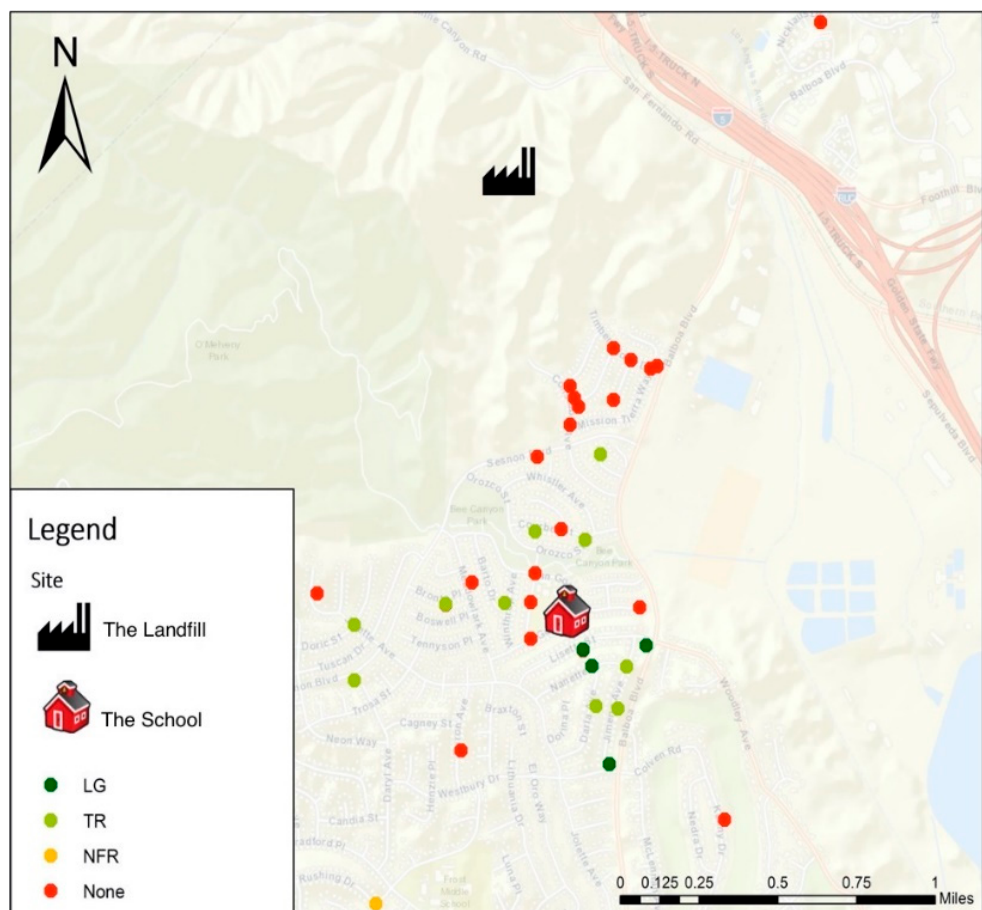
Figure 9. Odor Complaints near the school during the Odor Patrol time period: 6–9 a.m., 2016–2017. The dots do not represent each complaint, only the general location of complaints. LG–Landfill Gas, TR–Trash Odor, NFR–No Field Response:. The SCAQMD inspector did not go to the location, None: no odor was detected by the SCAQMD inspectors at the complaint site. Complaints near the school during the Odor Patrol time period: 6–9 a.m.